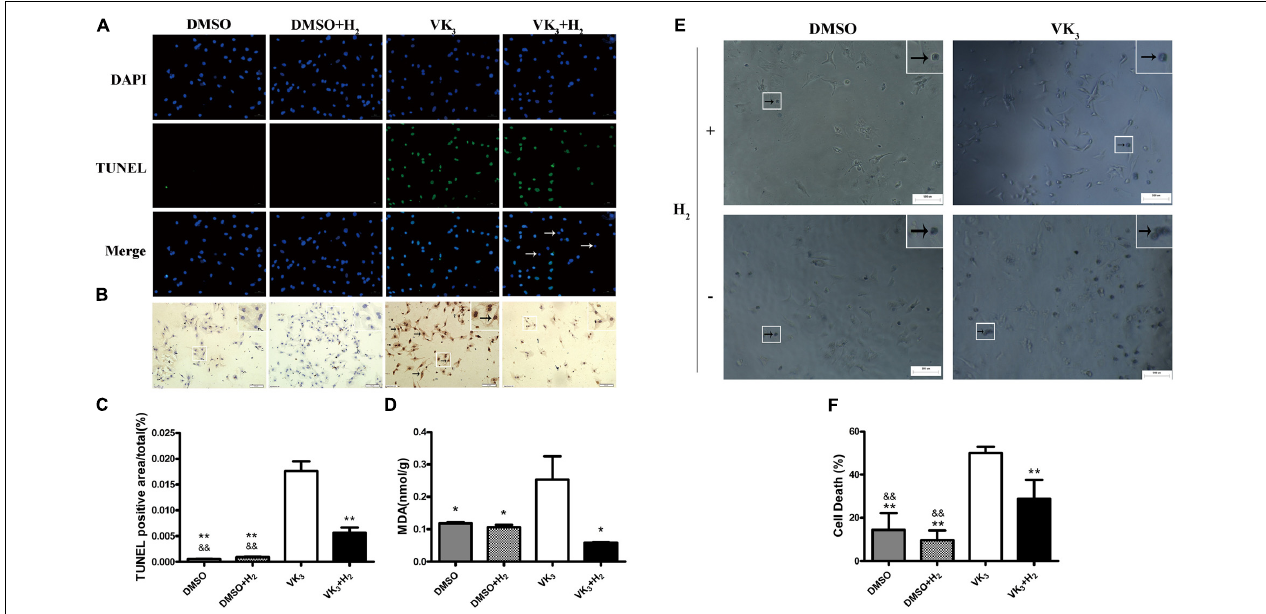
FIGURE 8 | Cell death and oxidative stress analyses for primary cardiomyocytes. (A) Apoptosis was detected by TUNEL assay. Representative photomicrographs of fluorescence are shown. Green nuclei represented apoptosis. All of nuclei were stained with DAPI (blue). After merging, blue-green nuclei represented apoptosis. Arrows represented the blue nuclei that were not apoptosis (Magnification of 100 × ). Scale bar = 500 µ m. (B) Representative photomicrographs of DAB staining are shown. Brown nuclei (arrows) represented apoptosis (magnification of 200 × ). Scale bar = 50 µ m. Inset: Magnified region illustrating non-apoptotic cardiomyocytes (blue nucleus) and apoptotic ones (brown nucleus). (C) TUNEL staining was quantified as the percentage of apoptotic cardiomyocytes (brown nuclei) of the whole section area ( n = 3). (D) MDA levels in primary cardiomyocytes are shown ( n = 3). (E,F) Cell death assay for primary cardiomyocytes ( n = 5). Representative photomicrographs of trypan blue staining are shown. Blue cells (arrows) represented cell death (magnification of 100 × ). Scale bar = 500 µ m. Inset: Magnified region illustrating dead cardiomyocytes (blue staining). The columns indicate the mean, and the bars indicate the SD. ∗ p < 0.05 vs. VK 3 ; ∗∗ p < 0.01 vs. VK 3 ; && p < 0.01 vs. VK 3 +H 2